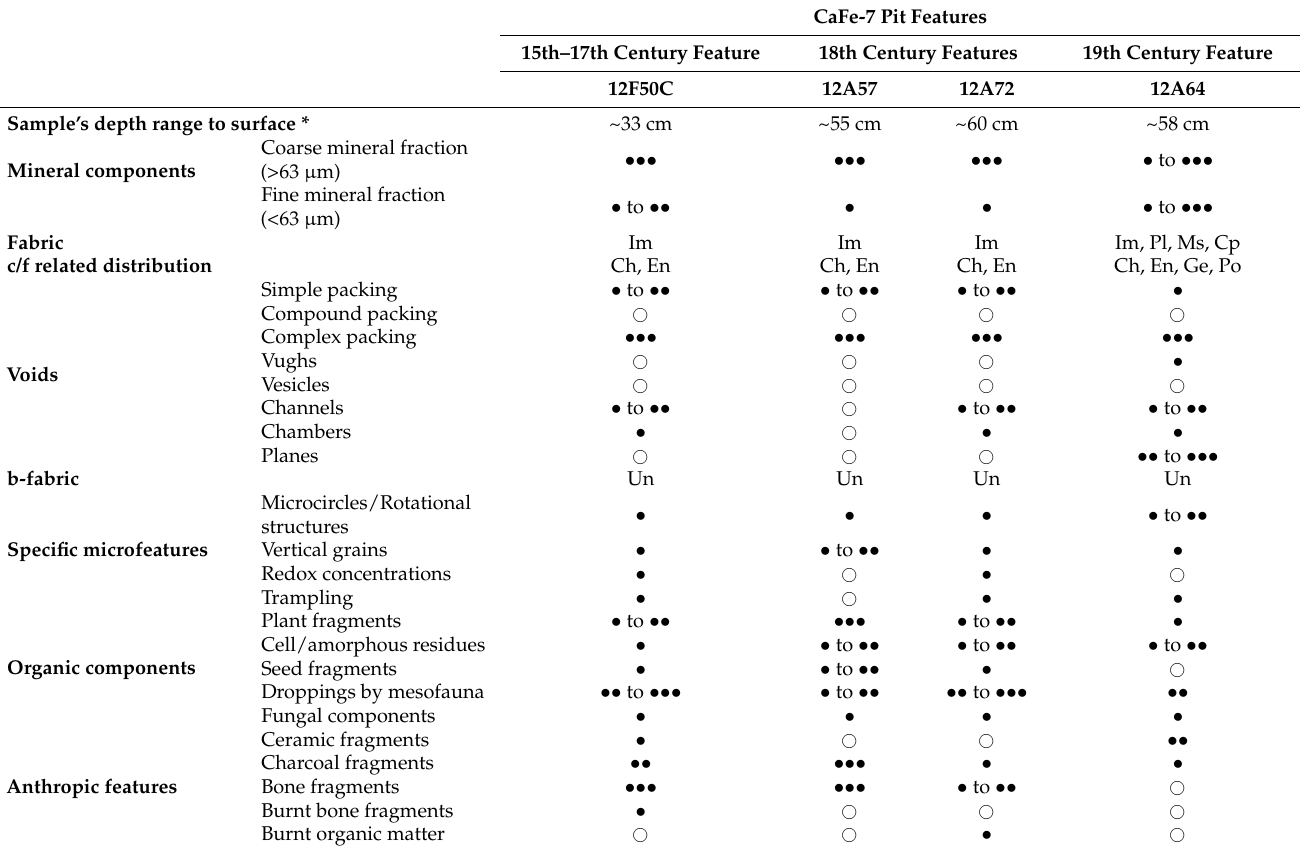
Table 7. Summary of micromorphological observations for the pit features of the Fort Odanak site